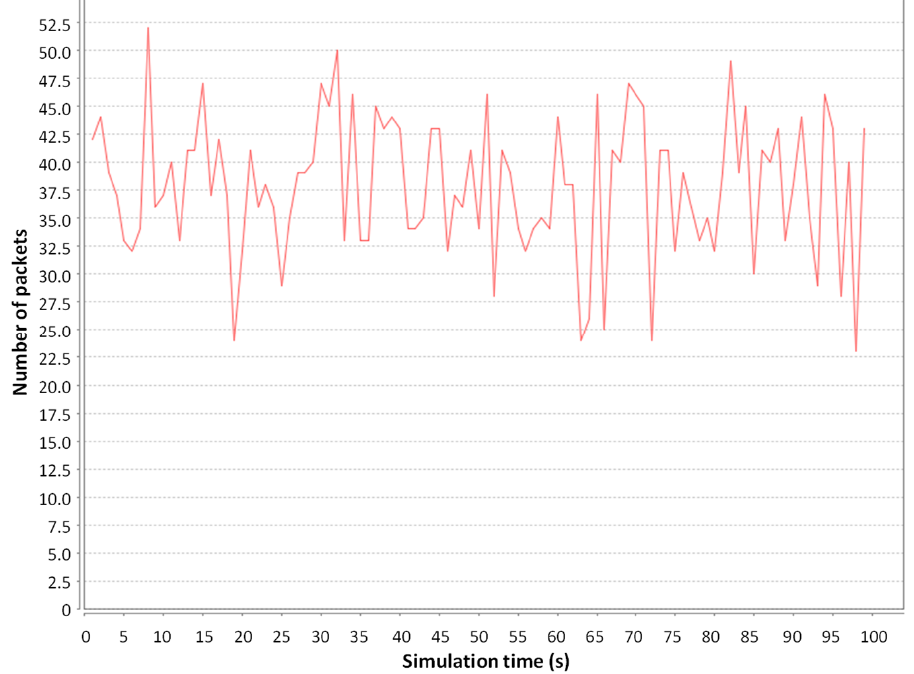
Figure 9. Intensity of the incoming load.